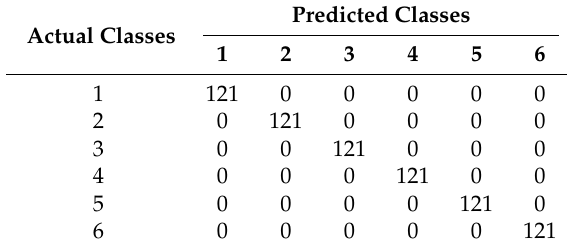
Table 5. Confusion matrix of the processing bearing fault data on test sets.